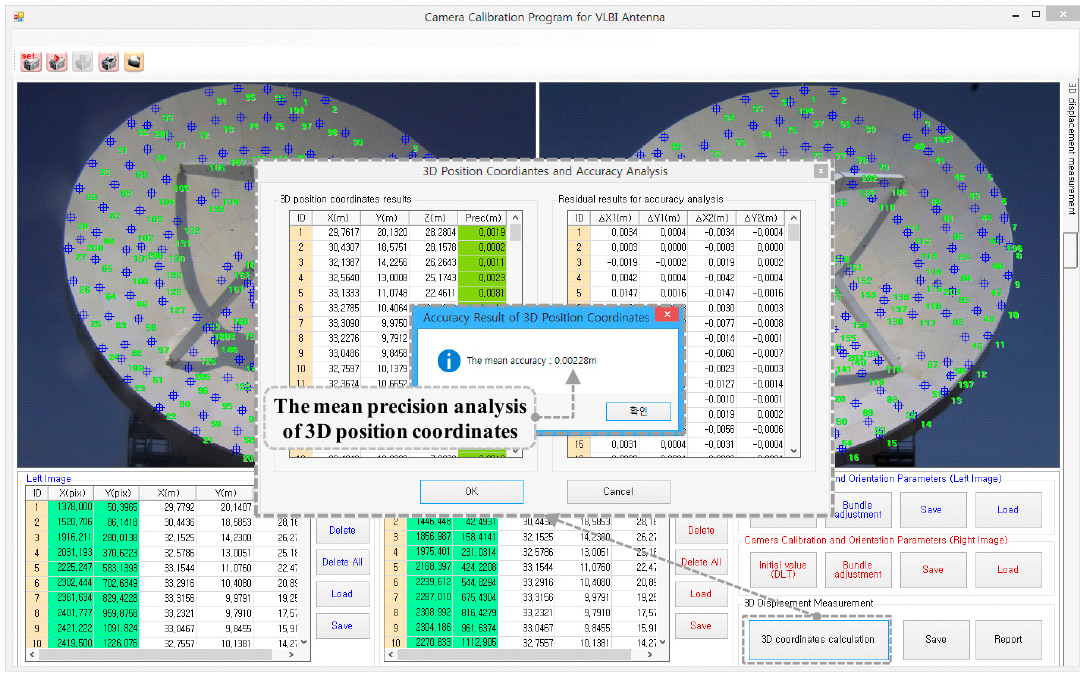
Figure 12. Measurement and accuracy analysis results for the 3D position coordinates from the developed software. Table 1. Statistical indicators of accuracy for the 3D position coordinates of the conjugate point compared with total station measurements.